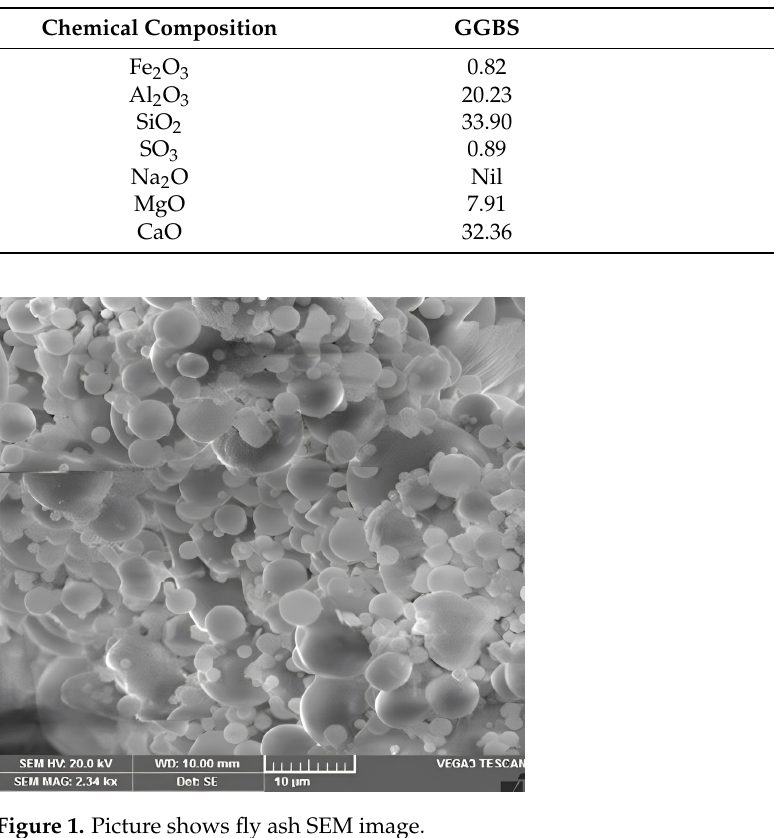
Table 1. GGBS and FA: Chemical Composition.